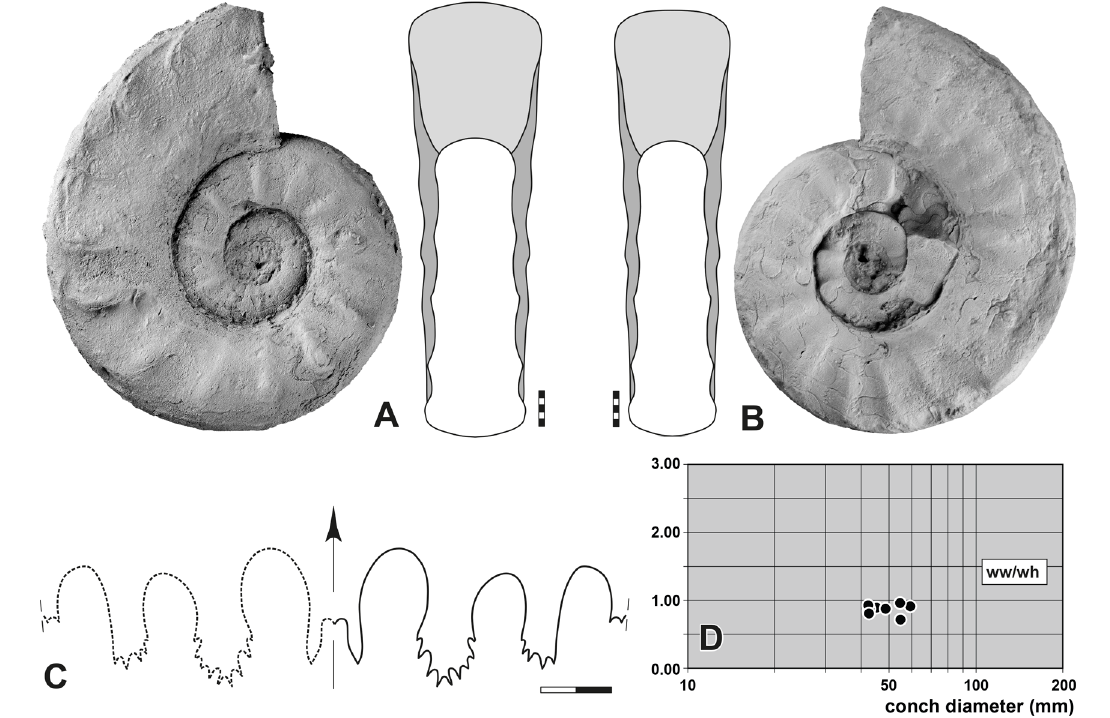
Fig. 58. Abichites ovalis Korn & Hairapetian sp. nov. A . Lateral and dorsal view, holotype MB.C.30059, section B, float. B . Lateral and dorsal view, paratype MB.C.30071, section G, -0.40 m. C . Suture line, holotype MB.C.30059, at 14.2 mm wh. D . Whorl profile proportions. Abbreviation: see Material and methods. Scale bar units = 1 mm.